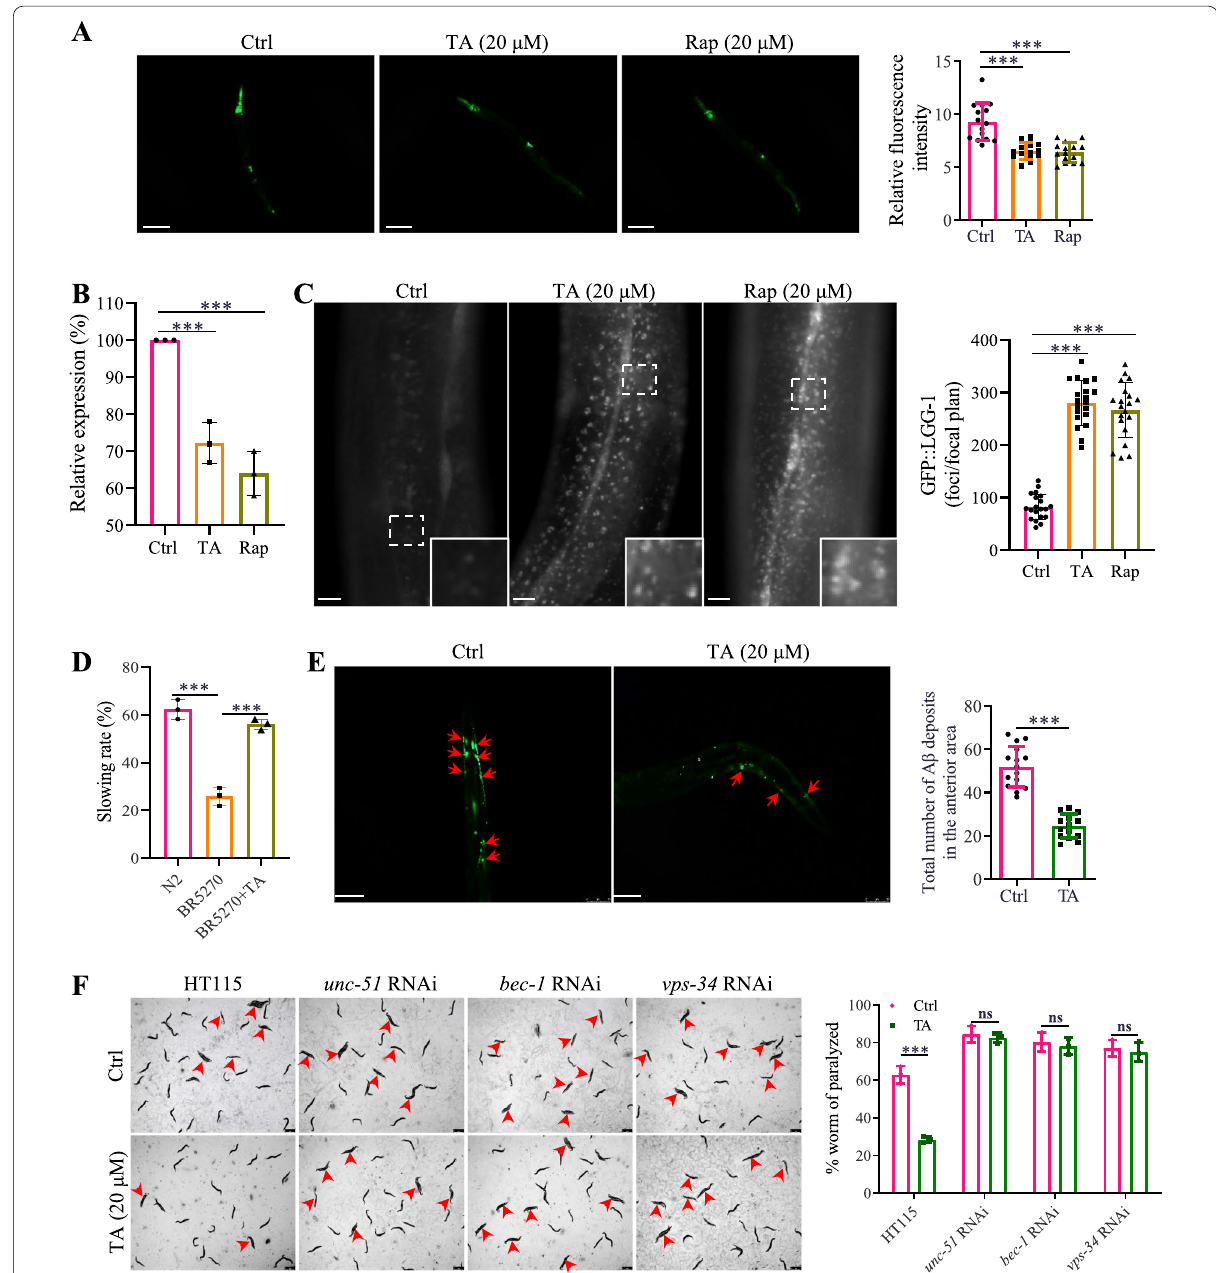
Fig. 6 TA induces autophagy and exhibits a neuroprotective effect in C. elegans . A Representative images of BC12921 worms with GFP representing the expression of p62. Magnification, 10; scale bar: 200 μm. The bar chart indicates the relative GFP intensity ( n 10). B The bar chart indicates × = the relative mRNA expression of p62 in worms ( n 10). C Representative images of DA2123 worms with GFP::LGG‑1 puncta. Magnification, = × 20; scale bar: 100 μm. Inset images displayed a higher magnification of the image in the dashed rectangle. The bar chart indicates the number of GFP::LGG‑1 puncta in worms ( n 10). The results were pooled from three independent experiments. The full image of worms is presented in = Additional file 1: Fig. S24. D The bar chart indicates the slowing rate of the N2 and BR5275 worms treated with or without TA (20 μM) ( n 60). E = Representative images of CL2331 worms with GFP representing the amount of Aβ deposits. Magnification, 10; scale bar: 200 μm. The bar chart × indicates the number of Aβ deposits in the anterior area of worms ( n 10). F Representative images of CL4176 worms treated with TA (20 μM) = in the presence or absence of unc-51 RNAi, bec-1 RNAi, or vps-34 RNAi bacteria were captured, and red arrows indicated the paralyzed worms. Magnification, 10; scale bar: 200 μm. The bar chart indicates the percentage of paralyzed worms ( n 60). Error bars, S.D. ** p 0.01; *** p 0.001. × = ≤ ≤ (One‑way ANOVA with Tukey‑corrected post hoc t ‑tests for multiple comparisons was applied for comparison between